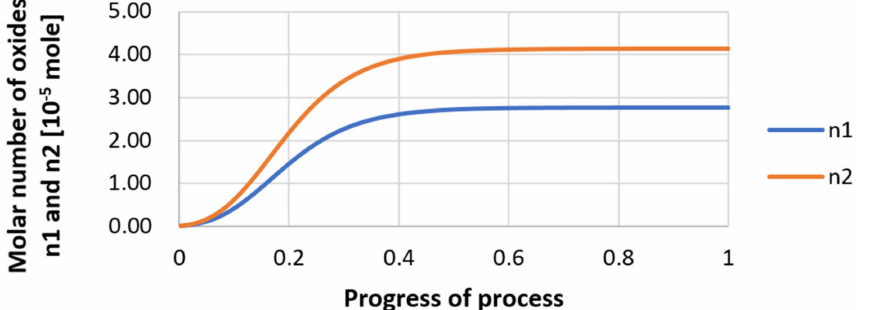
Figure 27. Growth of bi-component nuclei of sulfide n 1 (Y 2 S 3 ) and oxide n 2 (Y 2 O 3 ) in steel 3 (for r 0 = 1 µ m).